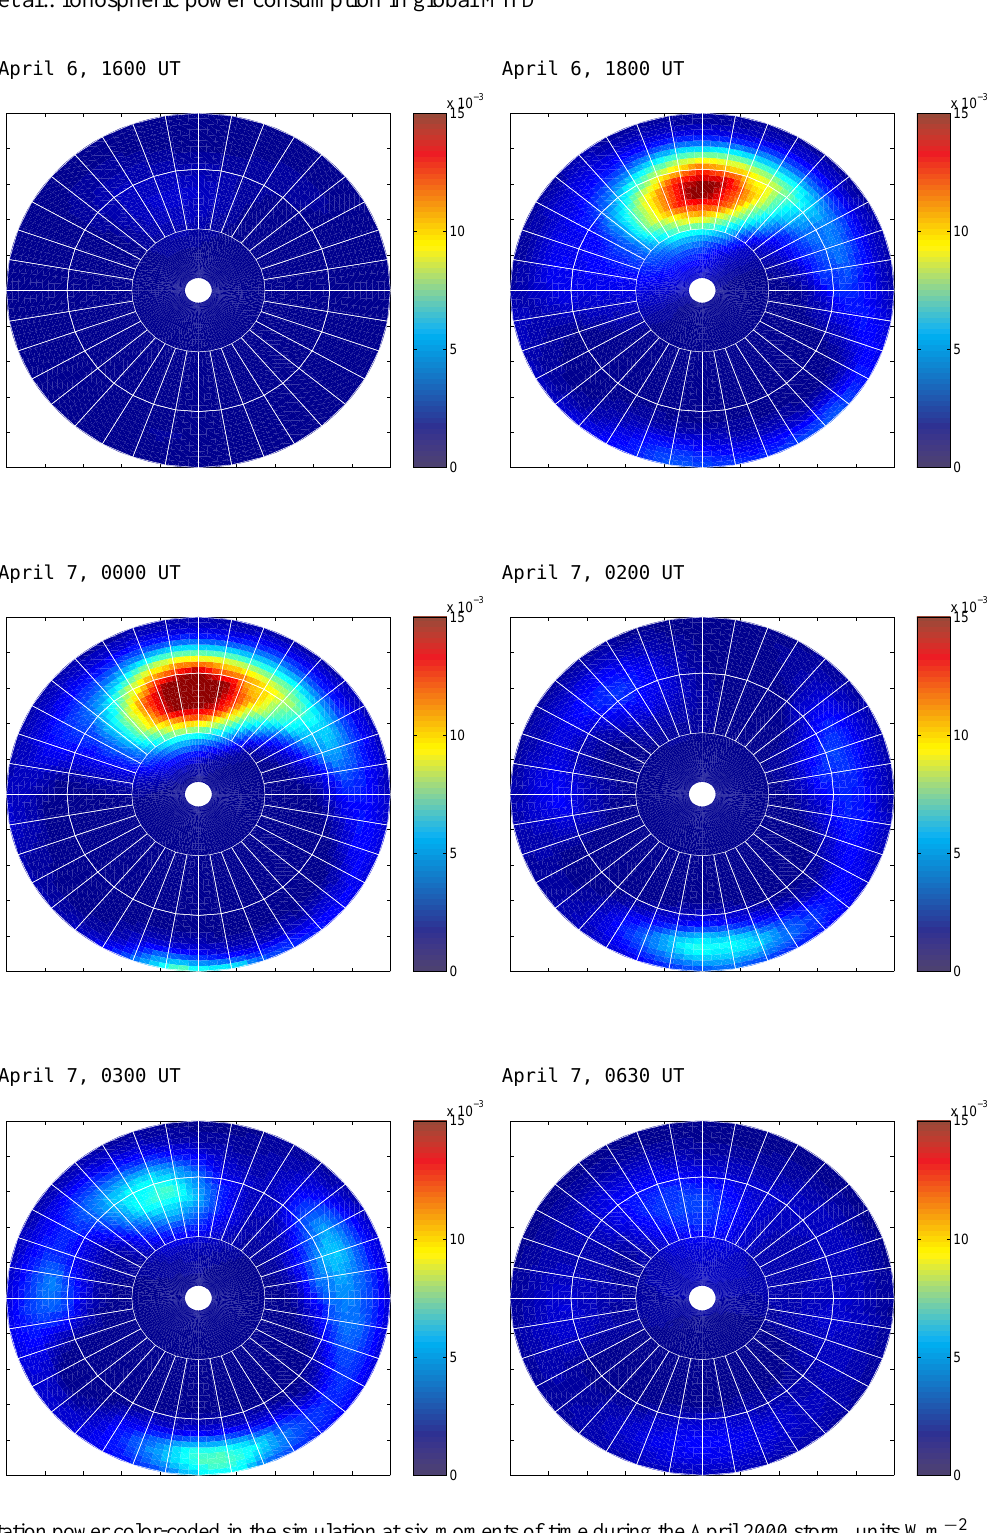
hour later the Joule heating power has already decreased to the level preceding the substorm. Figure 8 shows the precipitation color-coded in the simu- lation during the same time instant as above in Fig. 7, and the format of the figure is similar to Fig. 5 except for